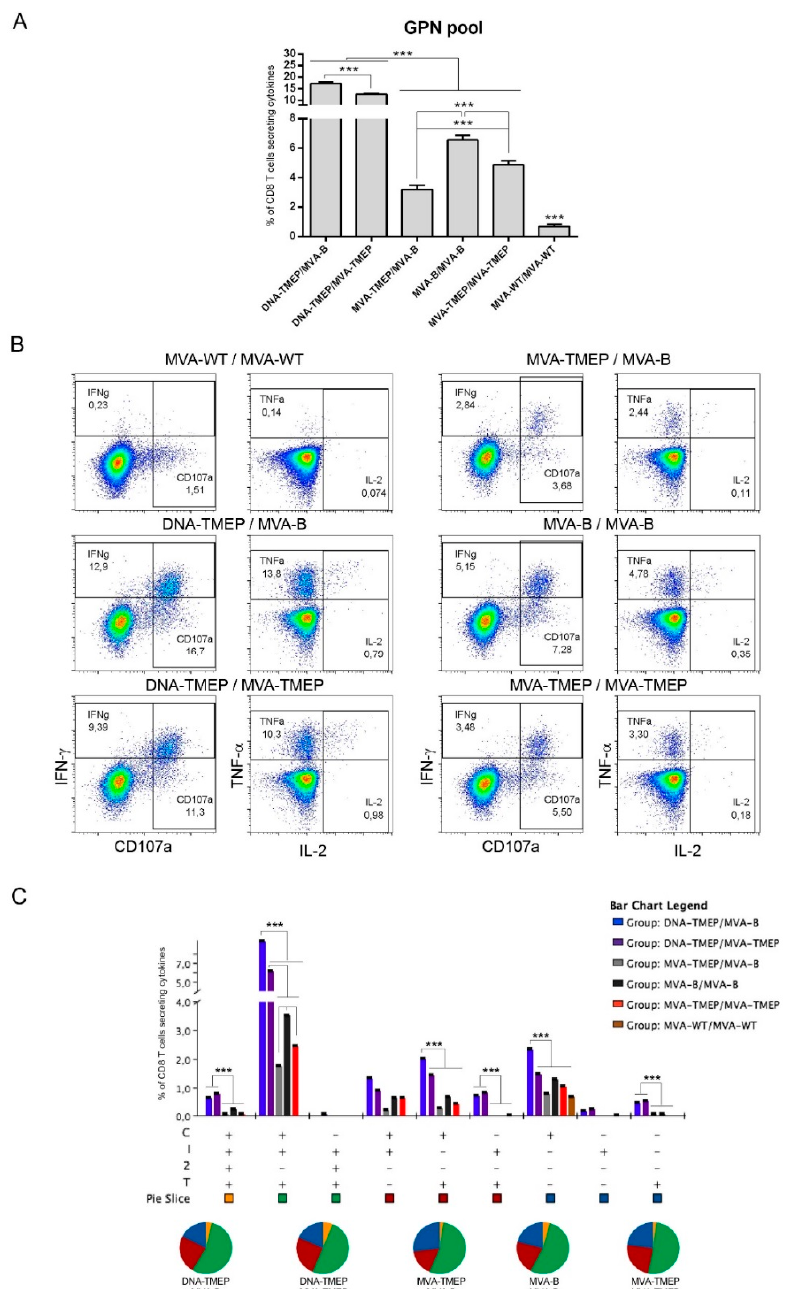
Figure 3. Polyfunctional Gag-Pol-Nef (GPN)-specific CD8 T cell responses induced in spleen after prime/boost immunization of mice with different DNA and MVA vectors expressing the TMEP-B protein. ( A ) Magnitude of the GPN-specific CD8 T cell responses determined at 10 days post-boost by ICS assay after the stimulation of splenocytes from immunized mice with the HIV-1 clade B consensus GPN pool. The total value in each group indicates the sum of the percentages of CD8 + T cells secreting IFN- γ and/or IL-2 and/or TNF and/or expressing CD107a against the HIV-1 GPN pool. Data are background-subtracted. ( B ) Flow cytometry profiles of the vaccine-induced CD8 T cell response against the GPN pool in the different immunization groups. ( C ) Polyfunctional profile of the GPN-specific CD8 T cell response. The percentages of the functionally distinct cell populations within the total CD8 T cells are represented on the y axis, while positive combinations of the responses are shown on the x axis. Responses are grouped and color-coded based on the number of functions. C: CD107a; I: IFN- γ ; 2: IL-2; T: TNF. Data from one experiment representative of two performed are shown and 95% CI is represented. ***, p < 0.001.